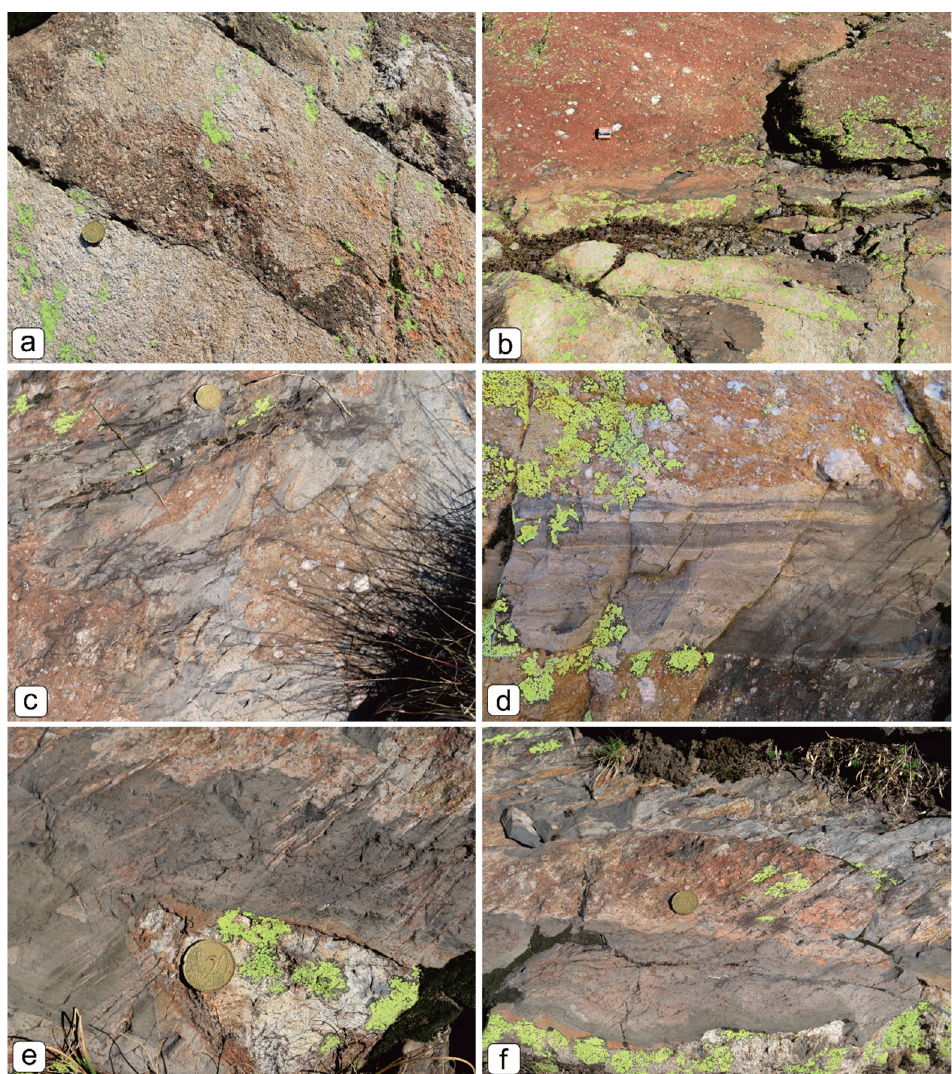
Figure 6. Field images of the main studied outcrop. ( a ) A tourmalinite vein propagated into the footwall paragneisses. ( b ) Reddish cataclasites after Mt. Aga Conglomerate with whitish quartz clast. They pass downward to gray cataclasites and black tourmalinites in contact with the footwall basement cataclasites. ( c ) Irregular contact between gray cataclasites/tourmalinites with the hosting reddish cataclasites, coin diameter is 22 mm. ( d ) Banded texture of tourmalinites with black levels made nearly entirely of tourmaline interleaved with gray-colored, partially tourmalinized cataclasites. ( e ) Alpine S 3 cleavage (top-right to down left) developed within the LANF fault core, coin diameter is 22 mm. ( f ) Undulated contact between tourmalinites and the host rock, coin diameter is 22 mm. Cataclasites are partially to completely substituted by tourmalinites. Field structural analysis suggests that tourmalinites seal the fault zone and maintain the same attitude of the LANF plane (Figure 4e), with only minor intrusion in the footwall as veins (Figure 6a). The Alpine deformation in the fault core and adjacent wall rocks unevenly resulted in the development of a non-pervasive slaty cleavage, mainly within fine-grained grey cataclasites (Figure 6e,f), but also within black tourmalinites (Figure 5f). The hanging wall is made of coarse-grained proximal conglomerates (Mt. Aga and Vedello conglomerate) with boulders of basement-derived gneisses and mica schists (Figure 5a), whereas the footwall consists of two mica gneisses with diffuse albite peciloblasts (Figure